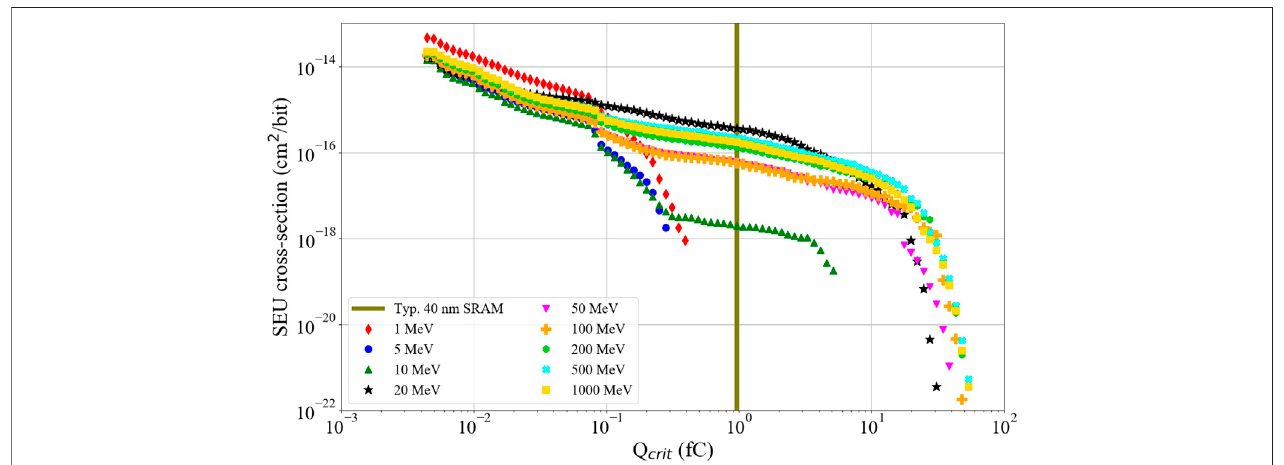
FIGURE 10 | FLUKA simulation ofSEU cross section obtained from the integral of the energy deposition distribution by mono-energeticphotons above Q crit in the RPP model representing an SRAM sensitive volume for SEU, plotted as a function of Q crit . The vertical line represents a typical value of the critical charge for 40 nm devices.